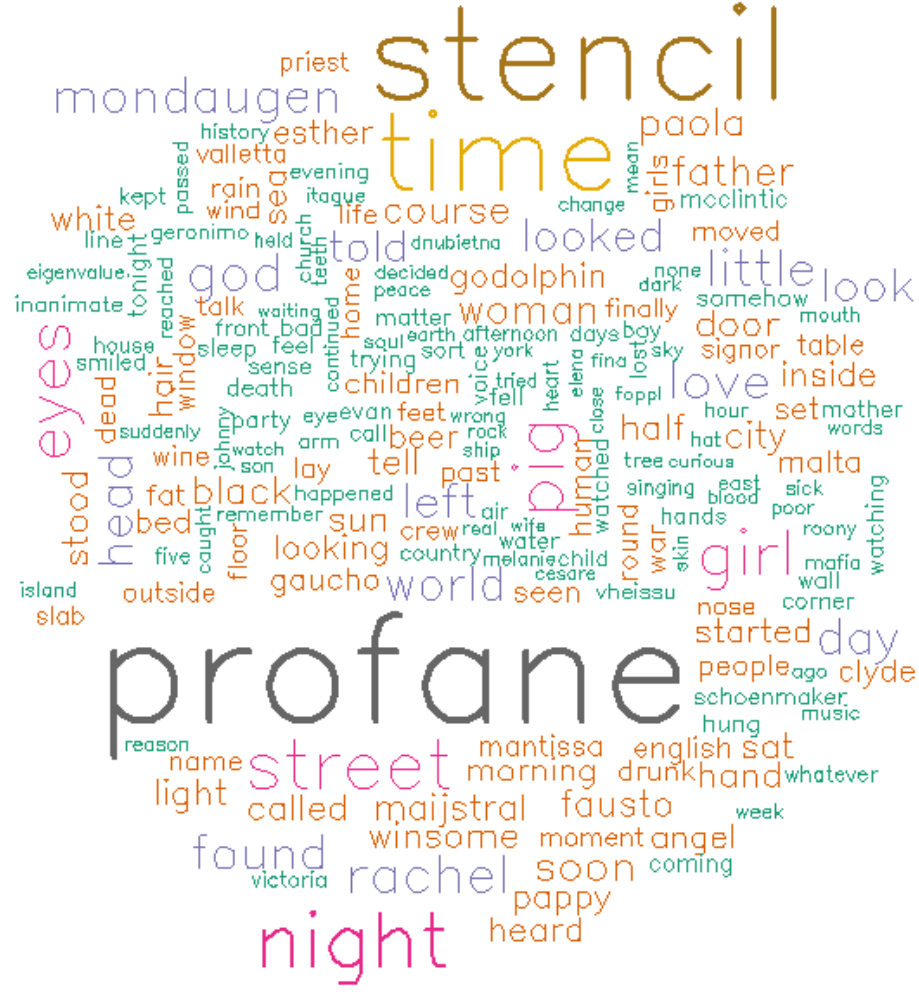
Figure 1: The 300 most frequent terms in the whole